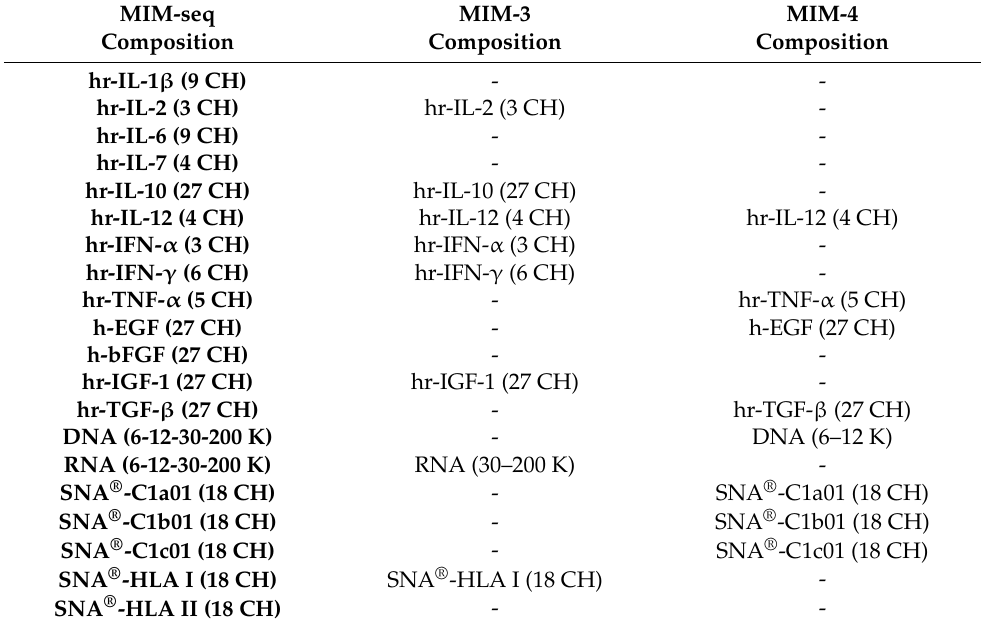
Table 1. Composition of the complete sequence of the MIM-seq (in vivo experiment) and the two tested capsules, MIM-3 and MIM-4 (in vitro experiments). CH: centesimal Hahnemannian; K: Kor- sakovian dilution; SNA ® : specific nucleic